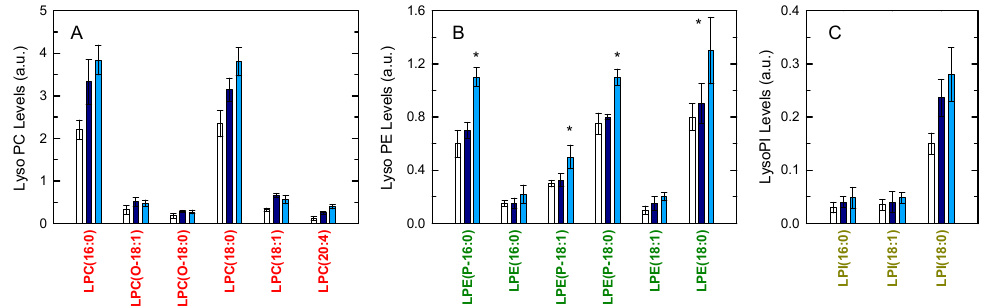
Figure 8. Lysophospholipid molecular species generated by macrophages and the effect of cellular stimulation. The cells were not stimulated (open bars) or were stimulated with 1 mg/mL zymosan (dark blue bars) or 1 mg/mL OpZ (light blue bars). After 1 h, the cellular content of lysoPC ( A ), lysoPE ( B ), and lysoPI ( C ) molecular species was determined by liquid chromatography/mass spectrometry (LC / MS). Results are shown as means ± S.E.M. ( n = 6). * p < 0.05, significantly di ff erent from zymosan-stimulated cells. a.u., arbitray